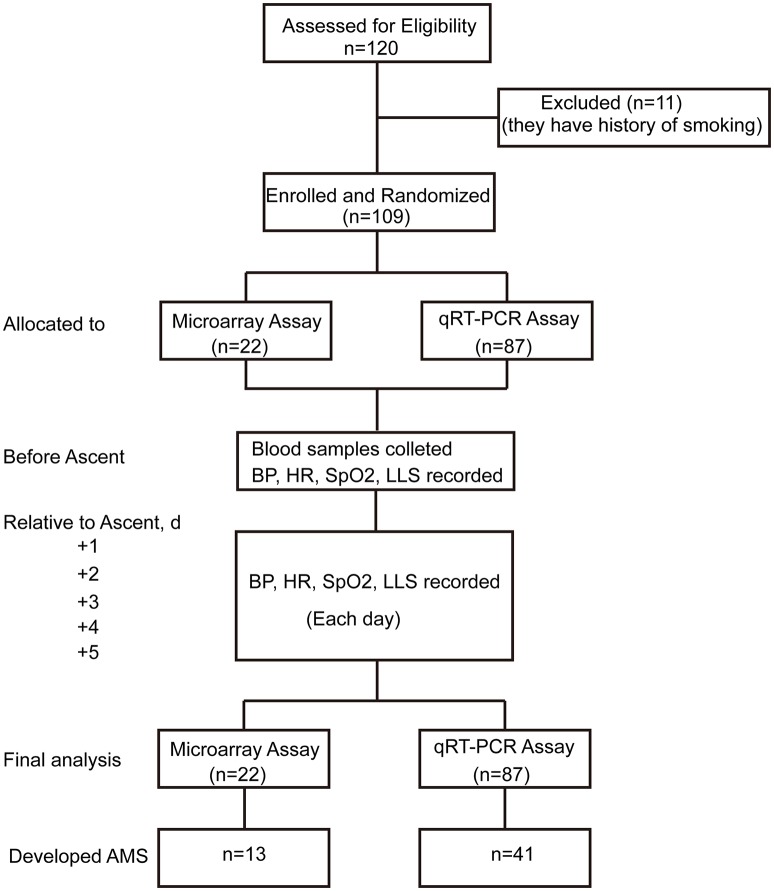
Trial flow diagram. AMS, acute mountain sickness; qRT-PCR, quantitative reverse-transcription polymerase chain reaction; LLS, Lake Louise Scoring System; BP, blood pressure; HR, heart rate; SpO2, oxygen saturation.